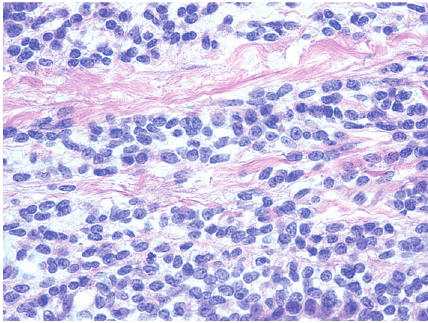
Figure 1: Tumour tissue. There are sheets of small round cells separated by fibrous tissue (H&E).